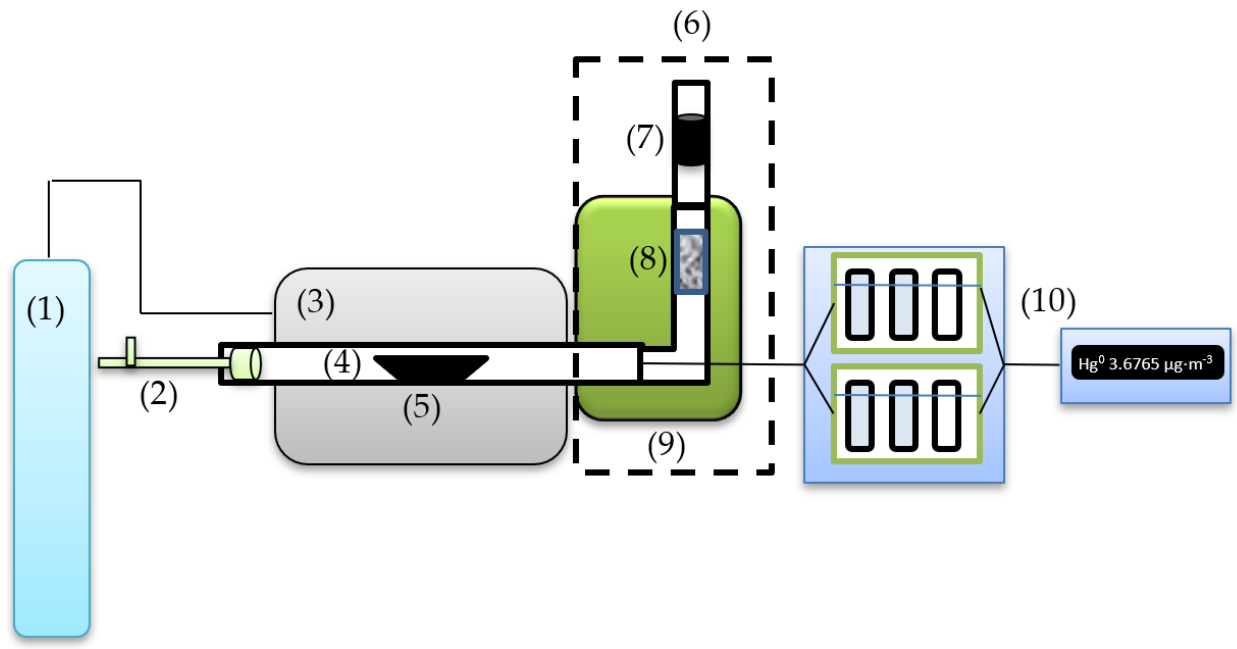
Figure 1. Test stand schematic: ( 1 ) gas source, air; ( 2 ) metal rod; ( 3 ) tube furnace; ( 4 ) quartz tube; ( 5 ) coal sample; ( 6 ) flue mercury adsorption device; ( 7 ) sorbent trap; ( 8 ) sorbent holder; ( 9 ) flue gases heating furnace; and ( 10 ) set of impingers with mercury survey meter EMP-3 of impingers for mercury speciation measurement .